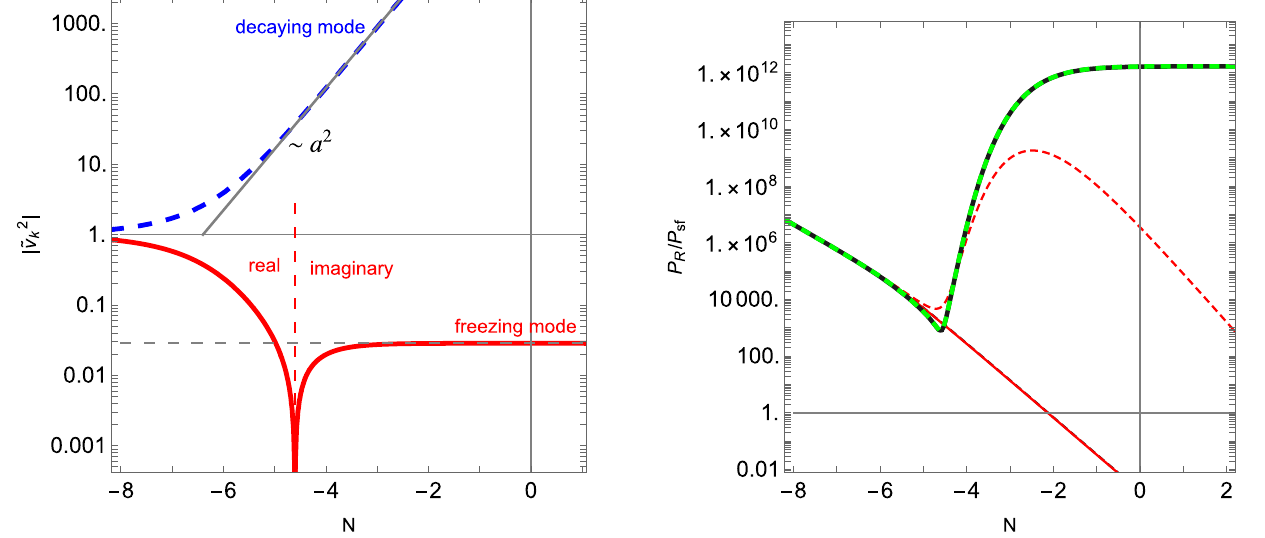
the sound speed squared, i.e. transition from real to imaginary sound speed, is indicated; thin dashed line corresponds to the value (22). Right panel: evolution of the instantaneous power spectra in the full theory and in the effective theory; color coding described in Table 1; N = 0 corresponds to the Hubble radius